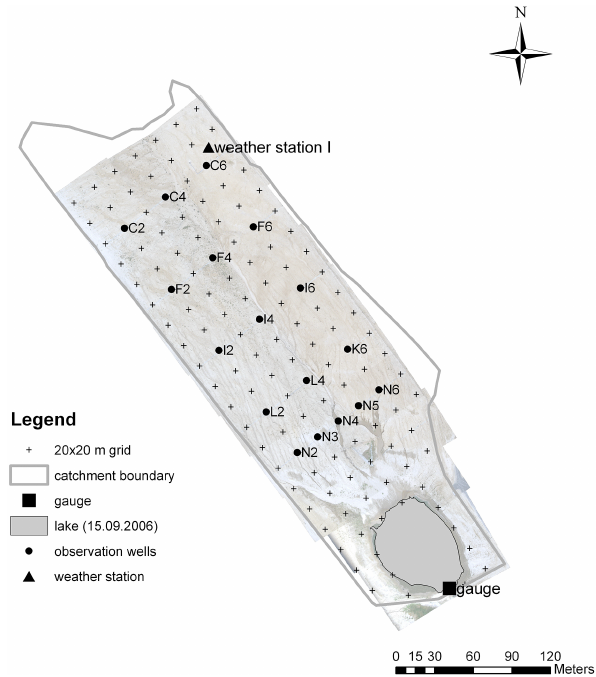
Figure 1. GIS framework of the Chicken Creek catchment.